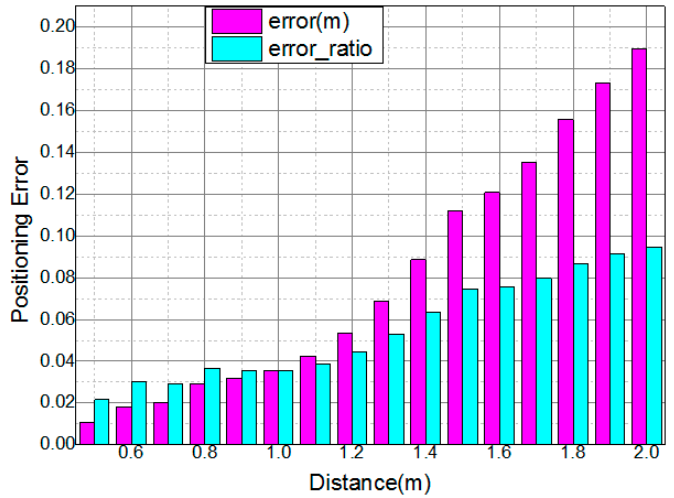
Figure 6. The normalized error and error ratio at different distances.